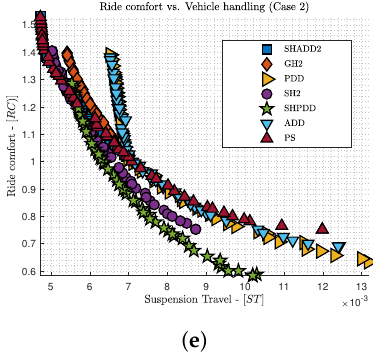
Figure 11. Comparison of the optimum suspension designs obtained for the two optimisation cases (Class A and B road profiles) for the various suspension types (PS, SH-2, ADD, SH-ADD-2, GH-2, PDD and SH-PDD) in Scenario 2: ( a ) RC vs. TW for Case 1; ( b ) RC vs. ST for Case 1; ( c ) RC vs. TW for Case 2 (first part); ( d ) RC vs. TW for Case 2 (second part); and ( e ) RC vs. ST for Case